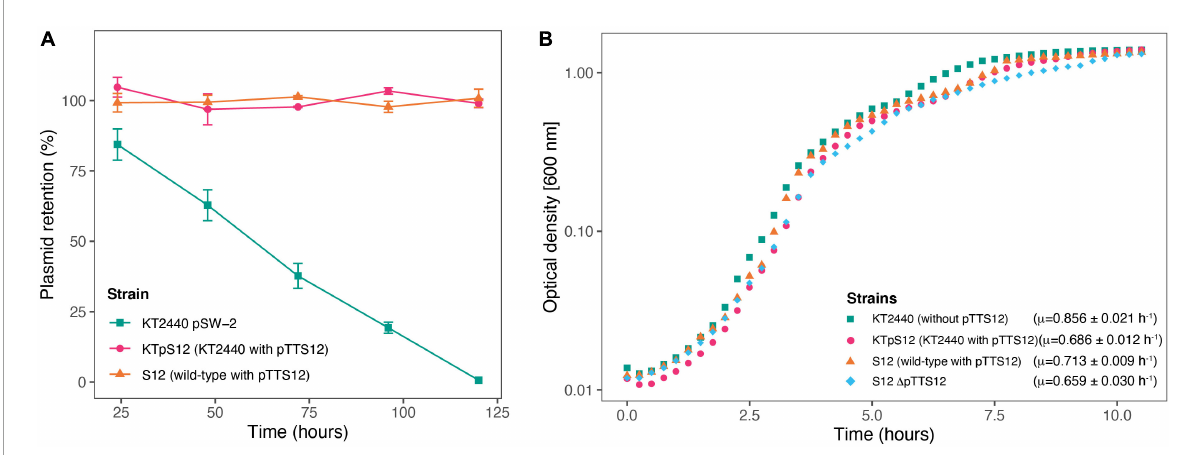
FIGURE4 Megaplasmid pTTS12 is highly stable in P. putida strains and reduces maximal growth rate in P. putida KT2440. (A) Plasmid retention of pTTS12 in P. putida KT2440 and P. putida S12 on liquid LB without selection pressure for approximately 50 generations. Colors and shapes indicate the different strains with green squares indicating P. putida KT2440 pSW-2, magenta circles indicating P. putida KTpS12, and orange triangles indicating P. putida S12 (containing pTTS12). Plasmid pSW-2 in P. putida KT2440 was used as a control for loss of unstable plasmid. pTTS12 is stably maintained in both P. putida S12 and P. putida KTpS12. (B) Growth curve of P. putida KT2440, P. putida KTpTTS12 P. putida S12, and P. putida S12 (cid:49) pTTS12. Growth was followed on liquid LB at 30 ◦ C, 200 rpm shaking. Growth curves represent data obtained from three biological replicates for each strain, starting from OD 600 nm = 0.05. Green squares indicate P. putida KT2440 pSW-2, magenta circles indicate P. putida KTpS12, orange triangles indicate P. putida S12 (containing pTTS12), and blue diamond indicate P. putida S12 (cid:49) pTTS12. Maximum growth rates calculated for each strais are indicated within the figure.